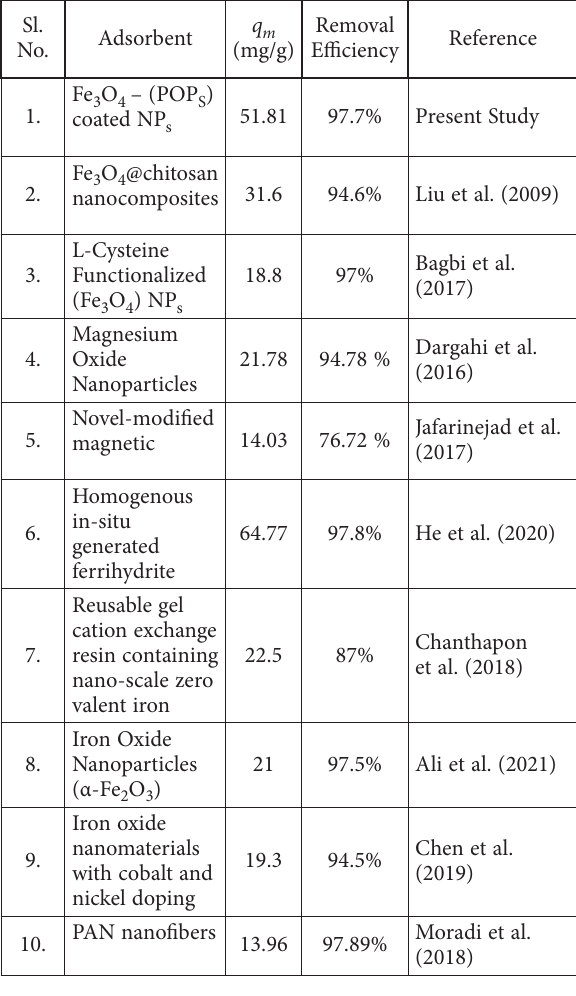
Table 4. Comparative table showing Pb removal using different adsorbents Sl.